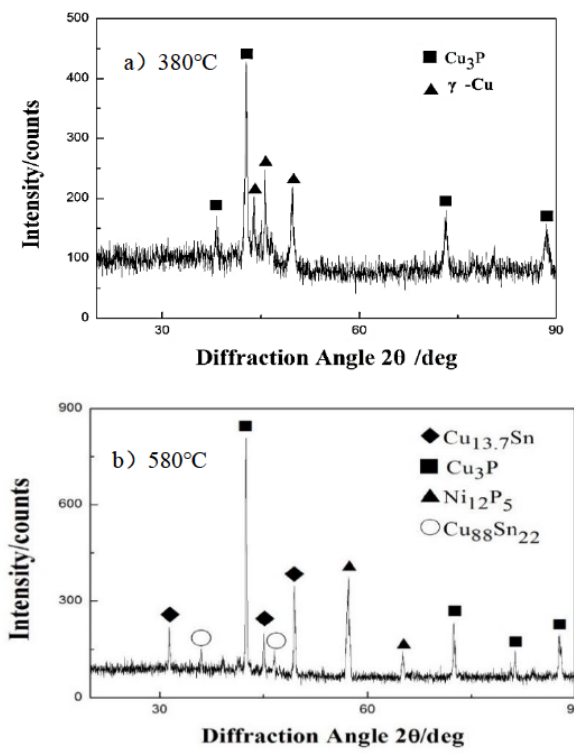
Figure 6: X-ray diffraction of the crystallization of amorphous filler metal during heating at (a) 380 and (b) 580 ∘ C